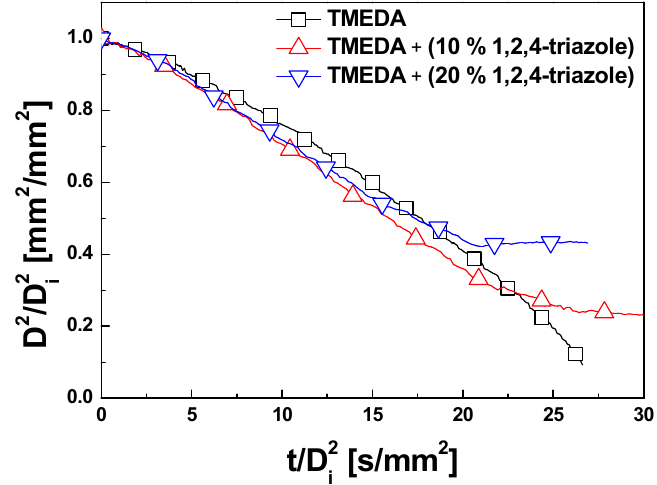
Figure 6. Normalized variation of evaporating TMEDA-based fuel droplet diameter squared with normalized time at 100 °C.